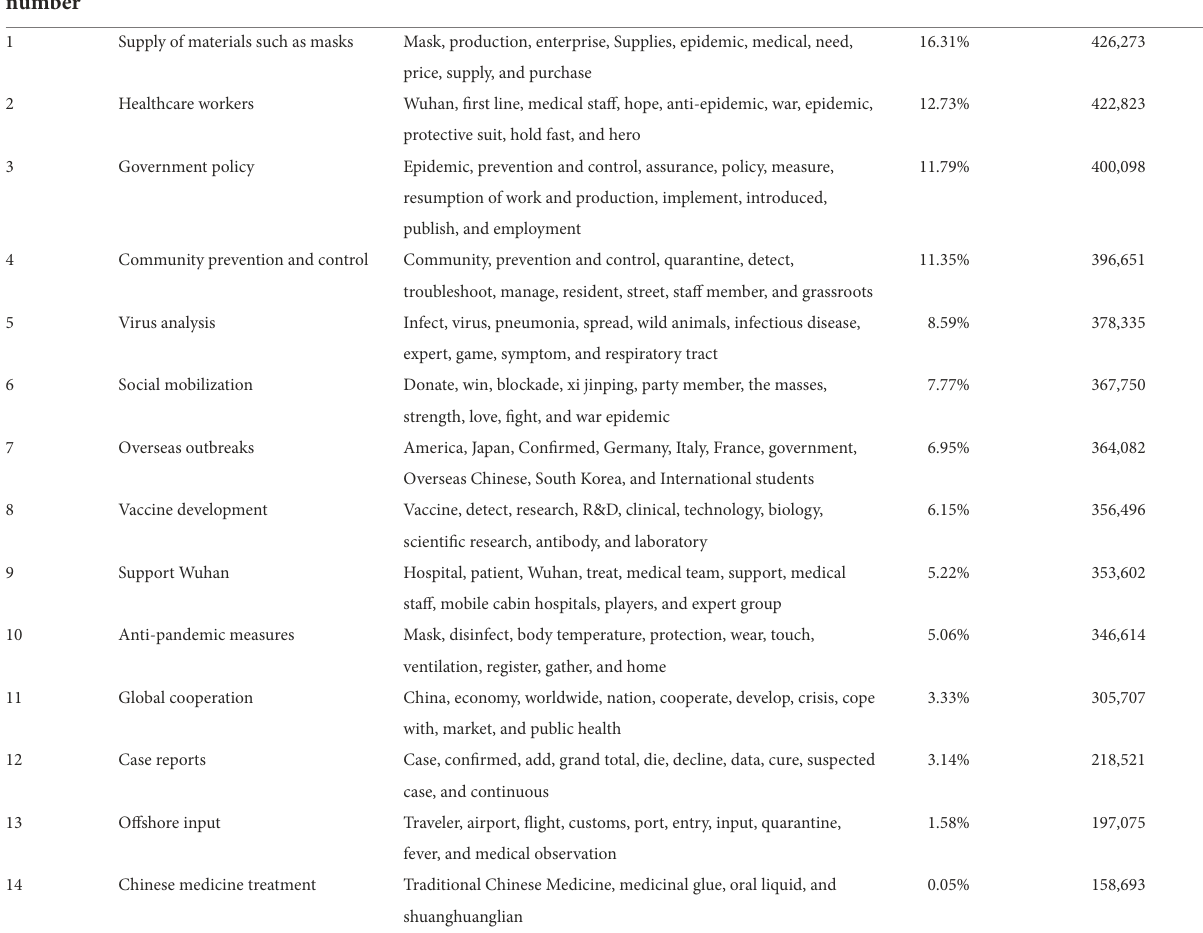
TABLE 5 The 14 topics related to the COVID-19